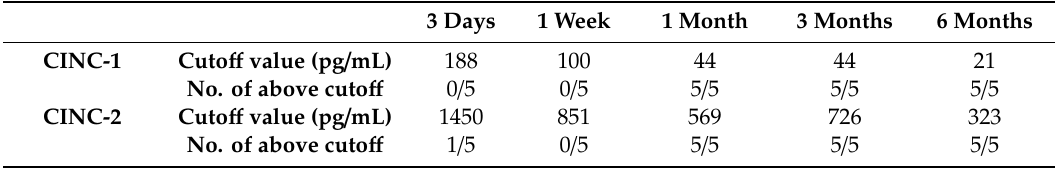
Table 3. Comparison of the cuto ff values and the concentration of CINCs following intratracheal instillation of SiO 2